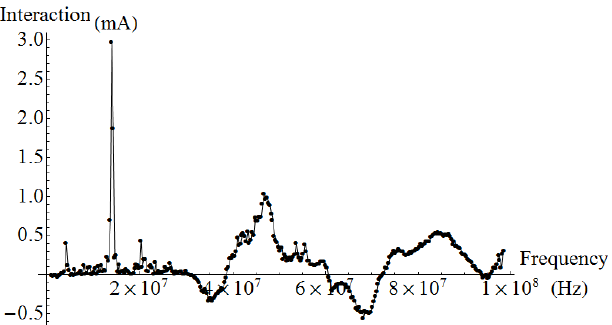
Figure 11: Interactions between both factors ( a But it is difficult to give further conclusions looking just at the variations of the effects with regards to the frequency.